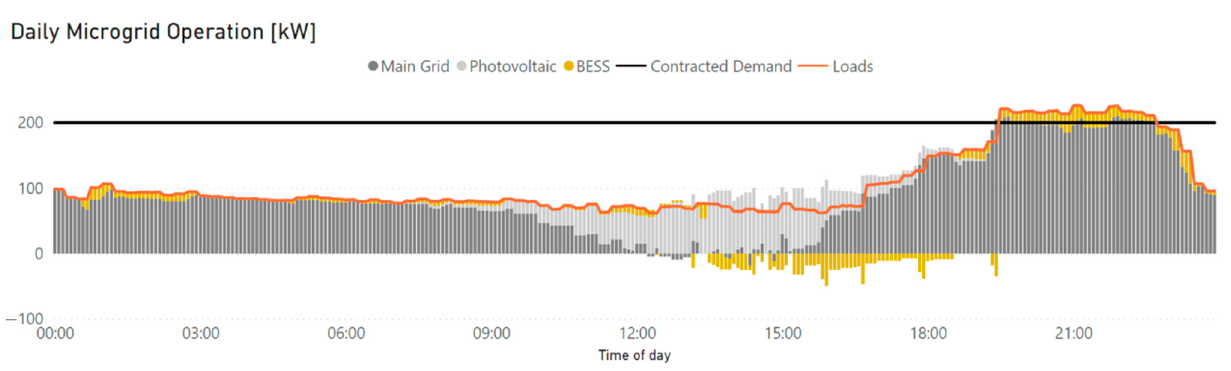
Figure 9. Daily microgrid operation for a contracted demand of 200 kW.